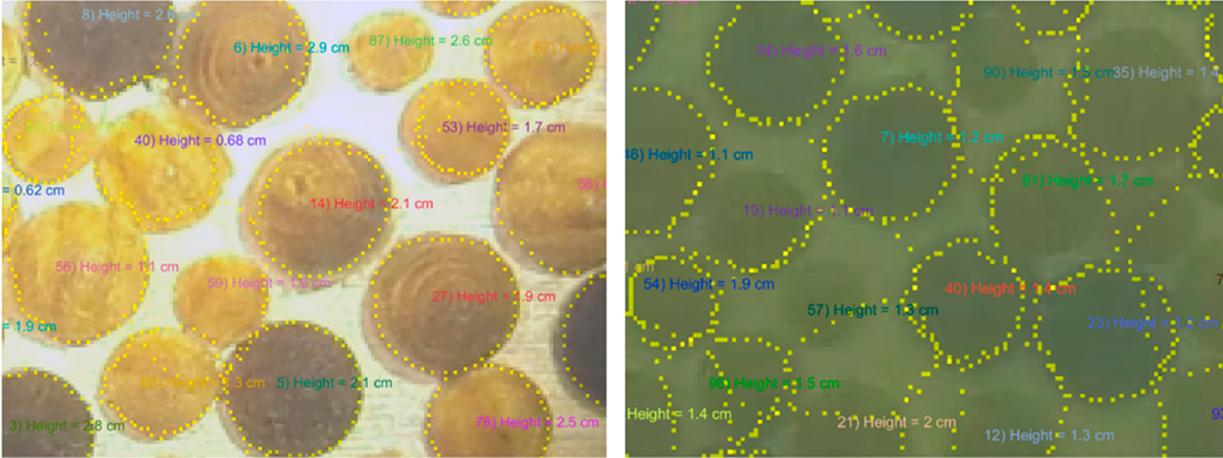
Figure 16. Results of segmentation of specimen for two configurations, 58 cm spot light ( left ) and 120 cm flood light ( right ). The asymmetry can be assessed by computing the skewness (Table 2).